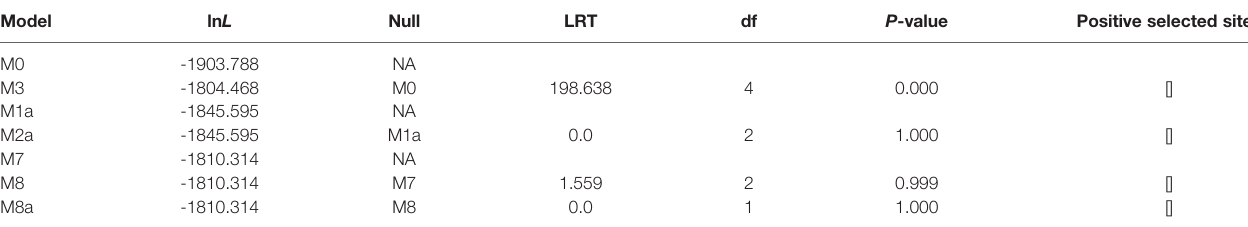
TABLE 4 | Positive selection analyses of razor clam Family I84 genes based on site model.